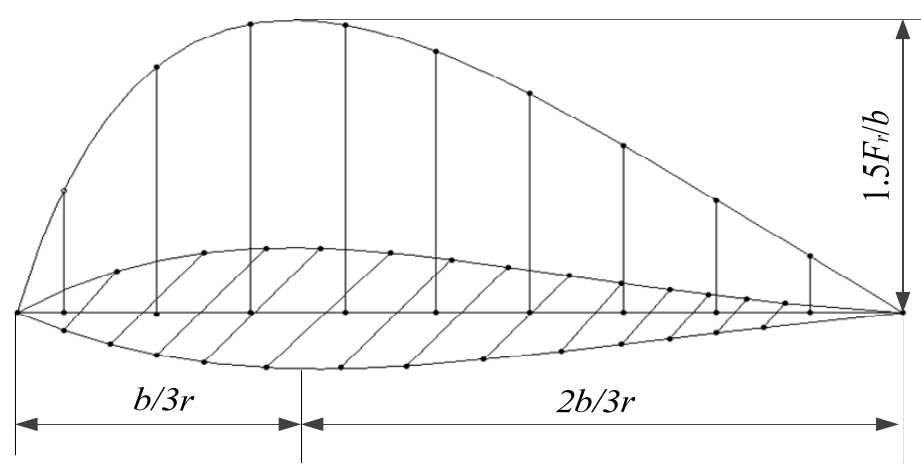
Figure 2. Inclined parabolic loading force distribution.